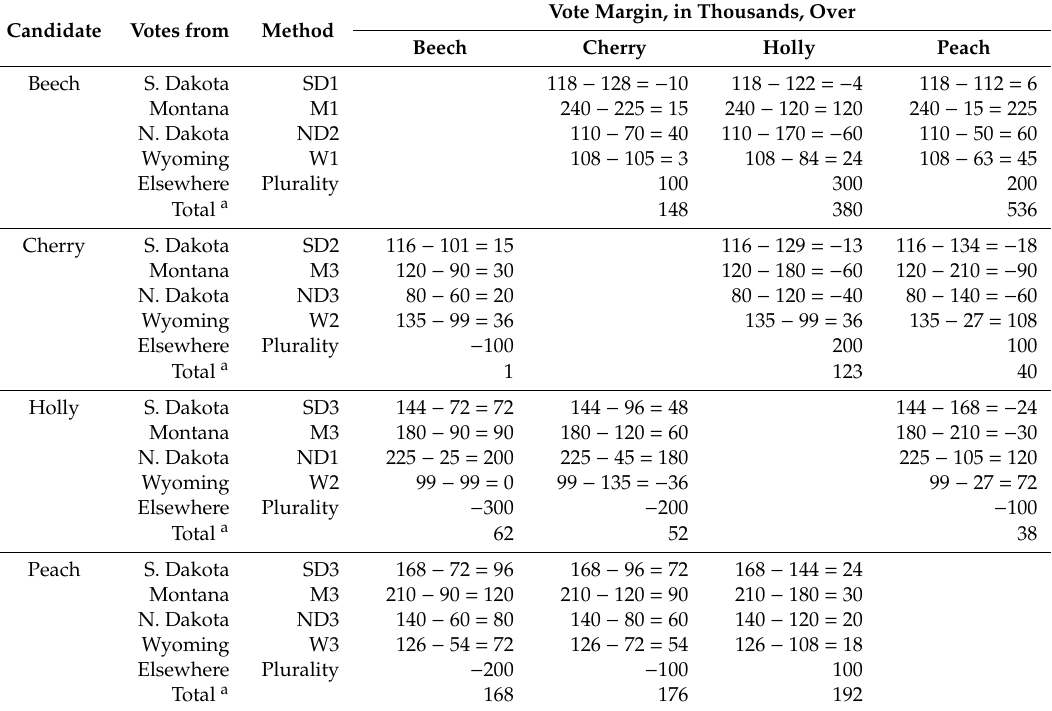
Table 10. Detailed calculations (with values from Tables 6–9) showing that any of the four candidates can win the nationwide total of pseudo plurality votes (four states) plus (ordinary) plurality votes (elsewhere) by using chosen methods for the former votes (2024 election, Scenario